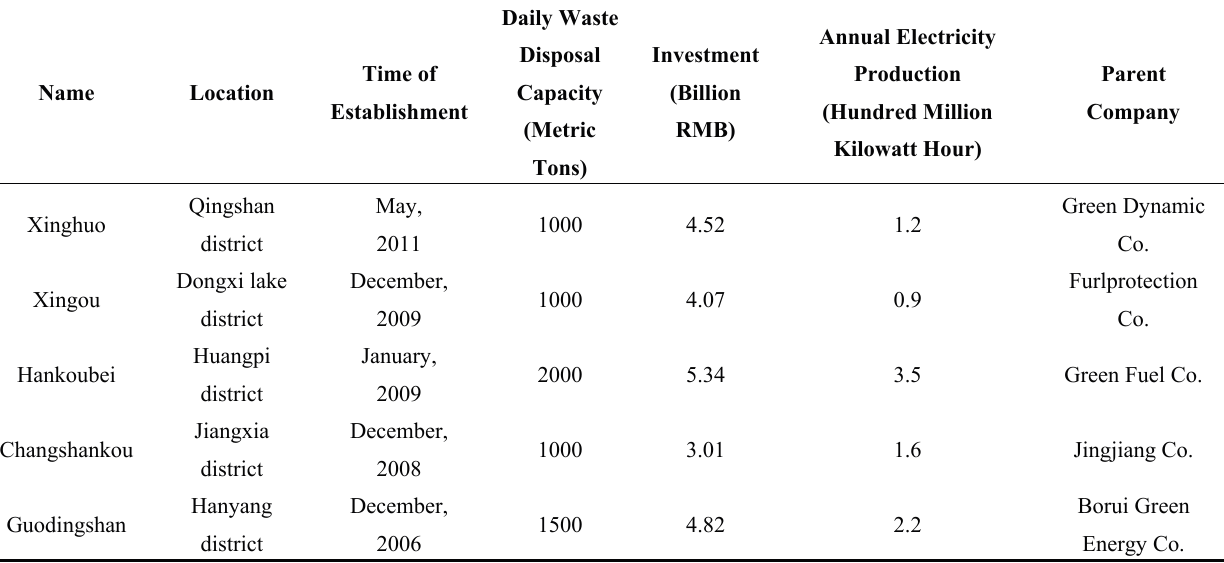
Table 2. General information of the incineration plants in